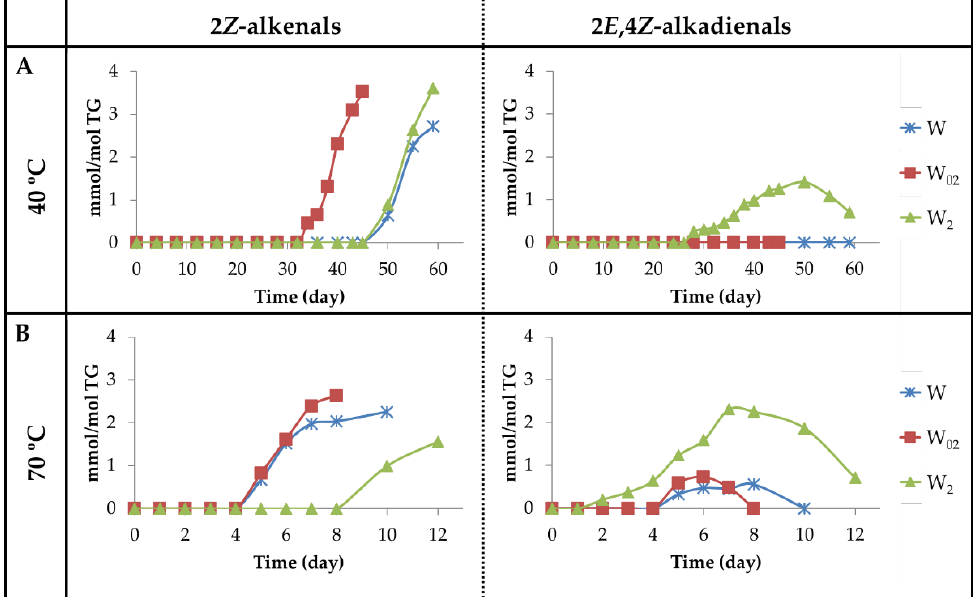
Figure 15. ( A ) Evolution of the concentration expressed as mmol/mol TG, of 2 Z -alkenals giving 1 H NMR signals near 10.05–10.07 ppm and 2 E ,4 Z -alkadienals in walnut oil with different enrichment levels of αT (W, W 02 and W 2 ) submitted to 40 °C up to advanced stages of the oxidation process. ( B ) The same at 70 °C.